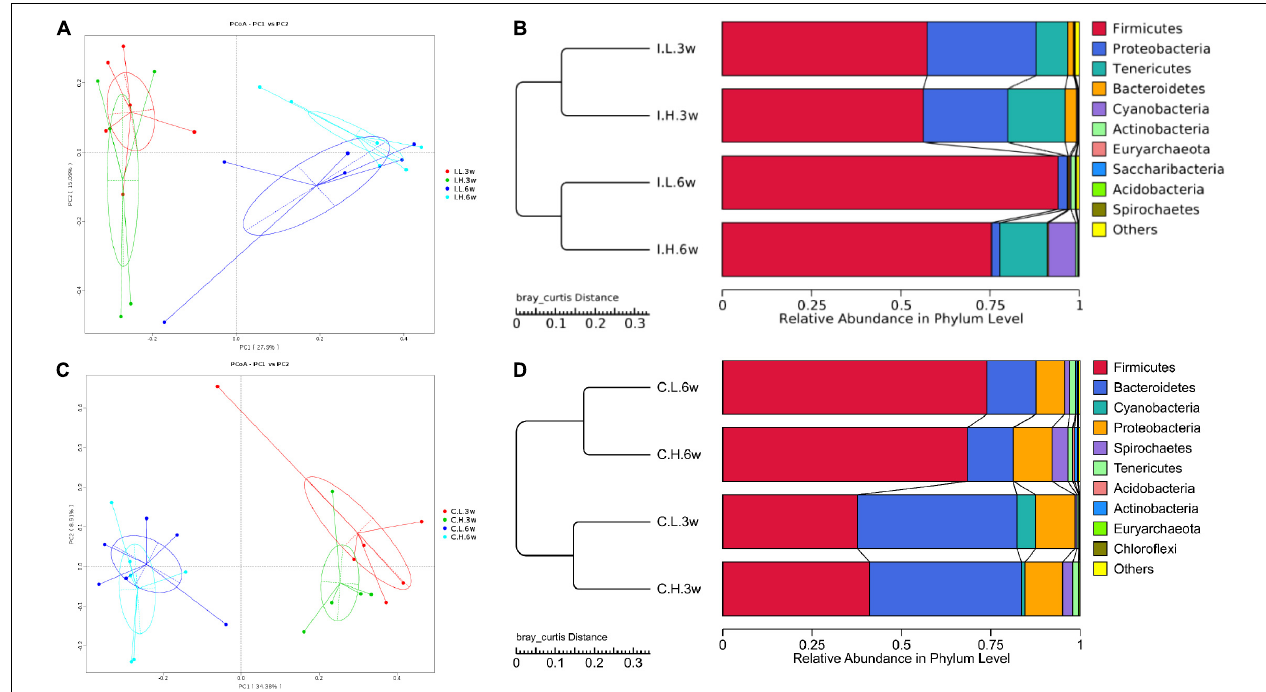
FIGURE 1 | Principal coordinate analysis and unweighted pair-group method with arithmetic mean (UPMGA) cluster analysis of microbial communities in the ileum and cecum of weaned piglets after 3 and 6 weeks of feeding. (A) Principal coordinate analysis (PCoA) of microbial communities in the ileum, (B) UPMGA cluster analysis of microbial communities in the ileum, (C) PCoA of microbial communities in the cecum, and (D) UPMGA cluster analysis of microbial communities in the cecum. I, ileal microbiota; C, cecal microbiota; L, control group; H, Cu-supplemented group; 3w, 3 weeks of feeding after weaning; 6w, 6 weeks of feeding after